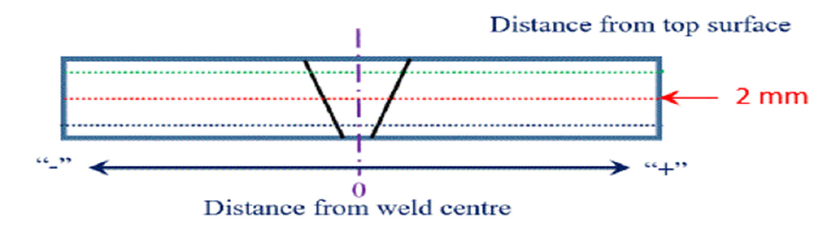
Fig. 4. Directions of measuring microhardness for the welded